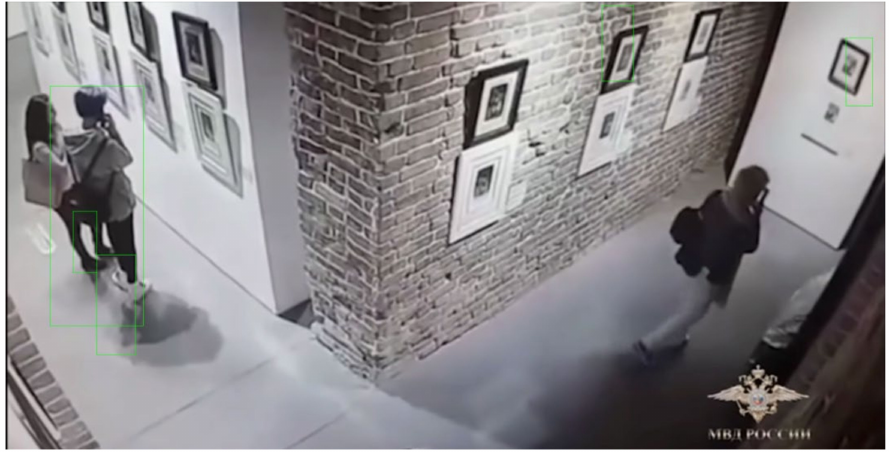
Figure 10. The detection logic output for a video stream.